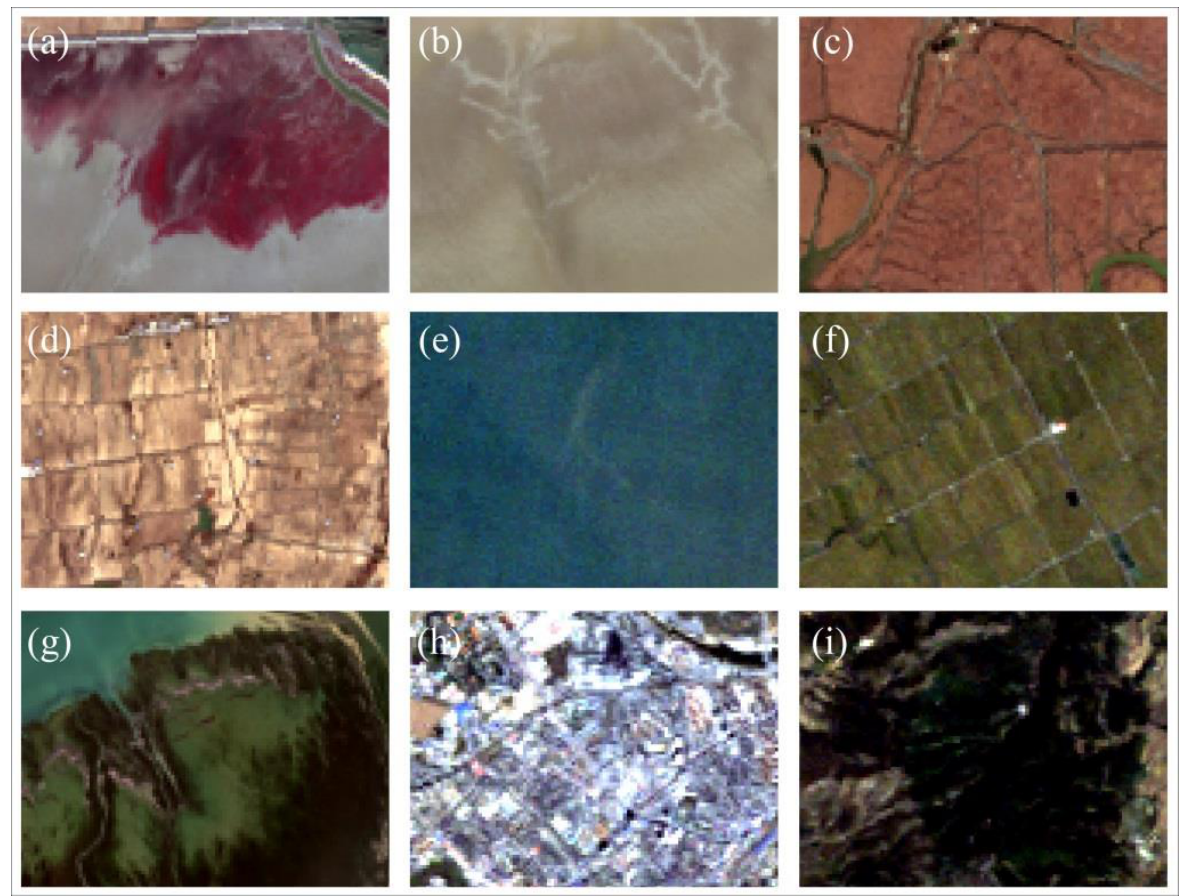
Figure 2. The nine different types of land cover in the Northern Yellow Sea of China: ( a ) S. salsa ; ( b ) mudflat; ( c ) reed ( Phragmites. australis ); ( d ) bare land; ( e ) water cover; ( f ) farmland; ( g ) smooth cordgrass ( Spartina alterniflora ); ( h ) reclaimed land; ( i )